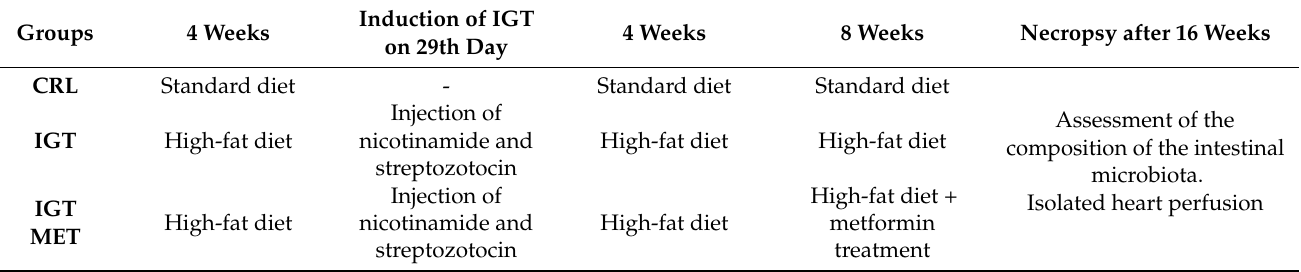
Table 1. Study design. CRL—control group, IGT—impaired glucose tolerance group, IGT MET— impaired glucose tolerance + metformin